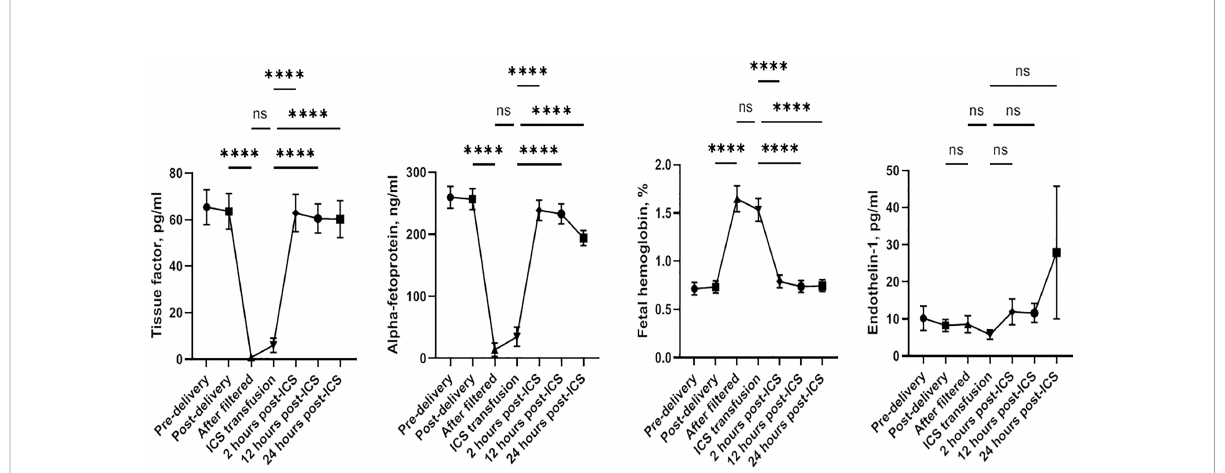
FIGURE 3 Changes of plasma levels of tissue factor, alpha-fetoprotein, fetal hemoglobin, and endothelin-1 before and after delivery and after blood transfusion. ****p < 0.0001; ns, not signi fi